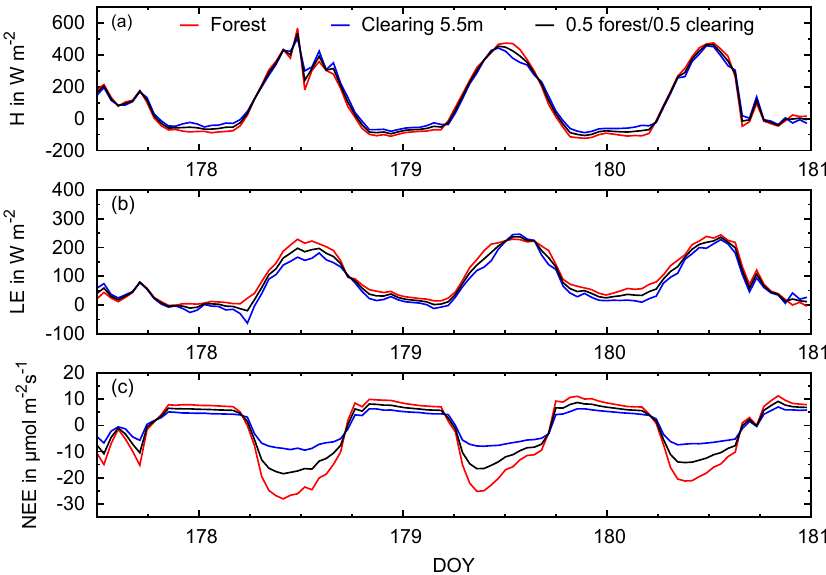
Figure 7. Main daily cycle of the (a) sensible and (b) latent heat flux as well as (c) NEE for the first golden day period modeled with ACASA for the forest (red line) and the clearing at 5.5m (tile approach for the different land use types of the clearing; blue line) and for a flux weighting of 50% clearing and 50% forest (black